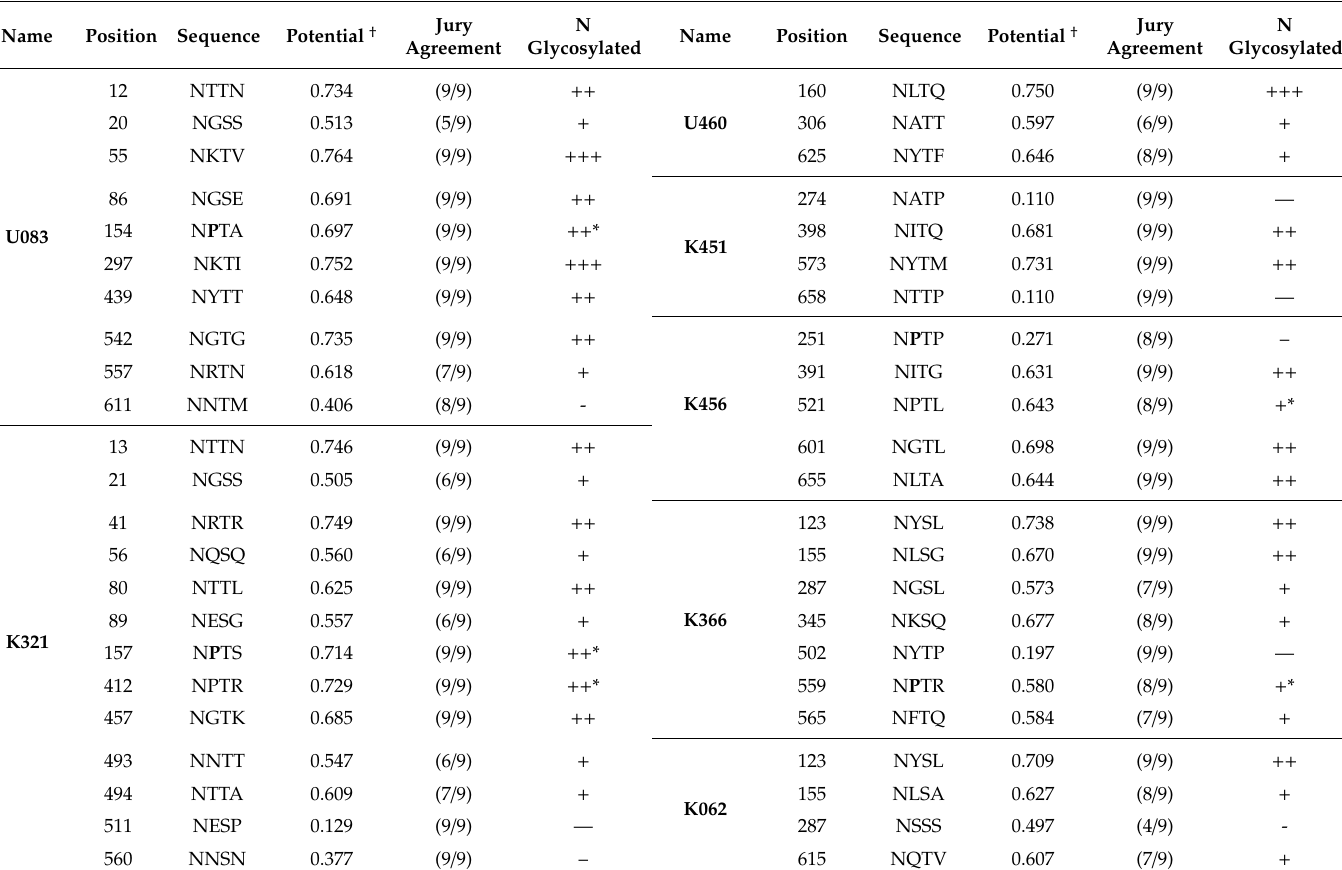
Table 4. Glycosylation analysis of the capsid proteins (ORF2) of astrovirus field strains using NetNGlyc